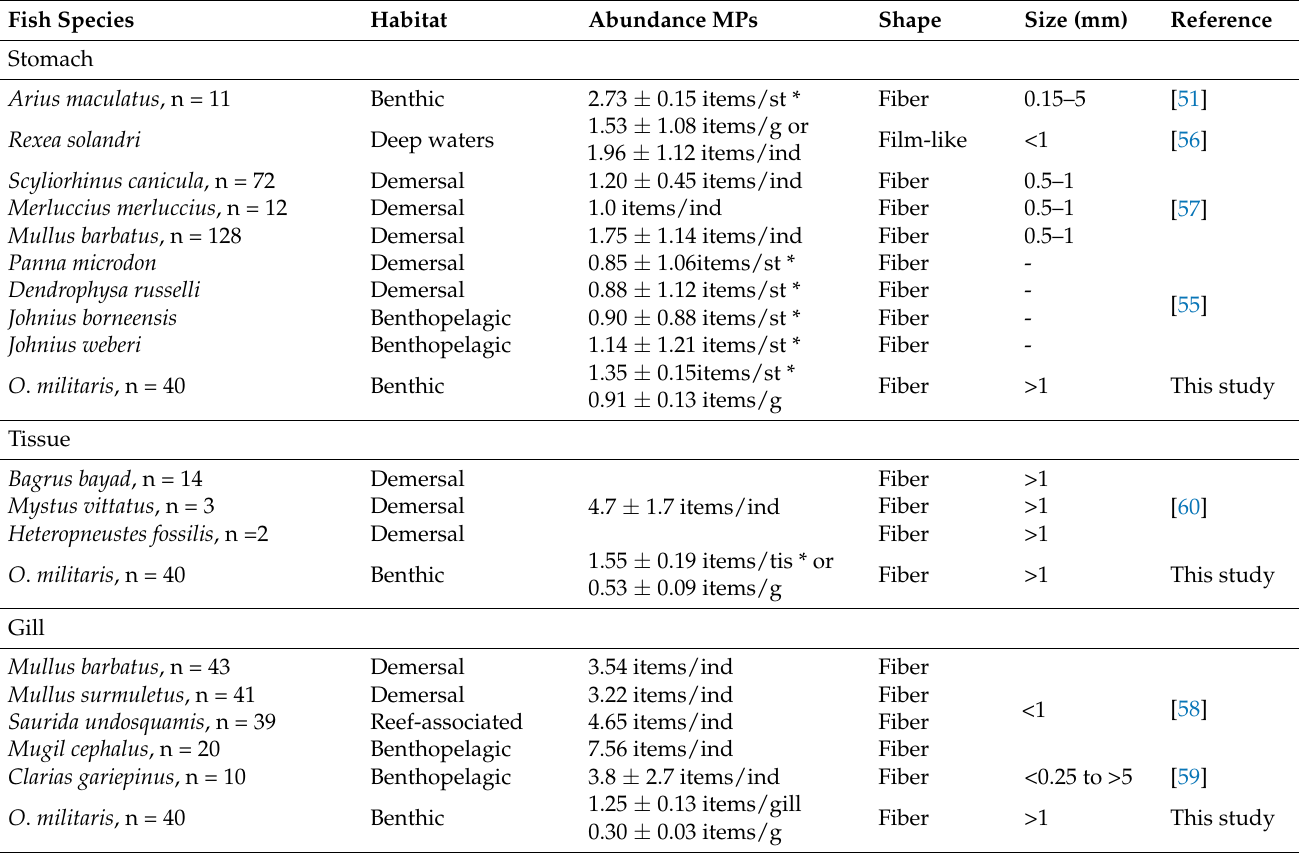
Table 2. Abundance and characteristics of microplastics in the stomach, tissue, and gills from several research